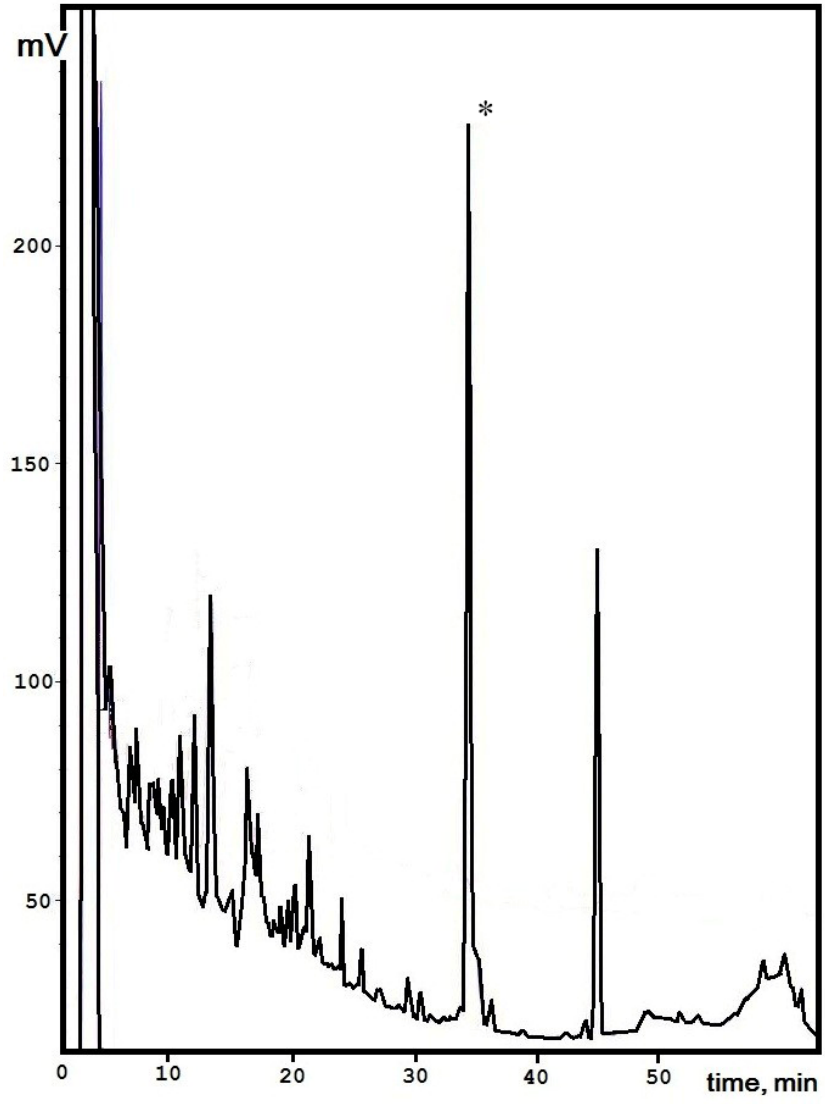
Figure 1. Isolation of Sa-HFB1 from S. alkalinus ethyl acetate concentrate. The target peak is indicated by in asterisk.